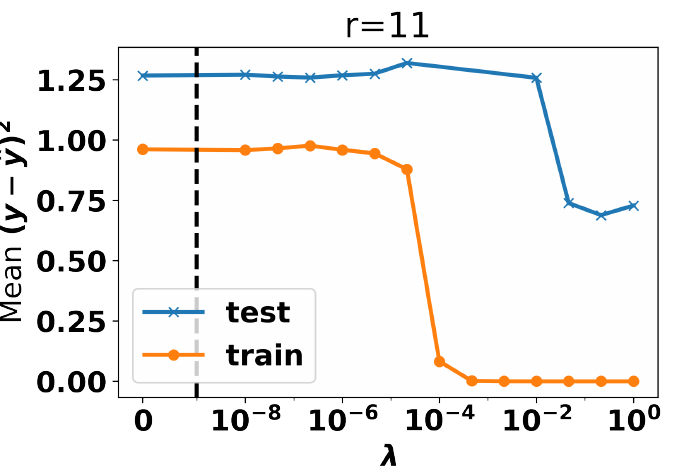
Figure 4. Errors in training and validation on Rate My Professor dataset with r = 11 topics. Points with λ > 0 for which the regression error exceeds 1.5 times the regression error at λ = 0 are not displayed. The dashed vertical line is the transition point between a linear and logarithmic x